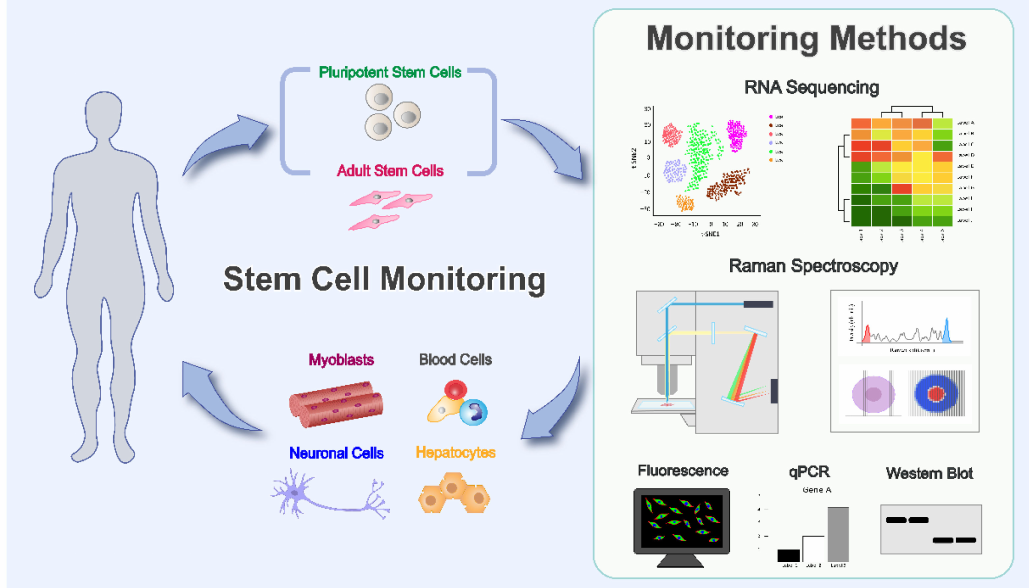
Figure 1. Schematic of the process of cell therapy using various stem cells and methods of tracing the lineage of these stem